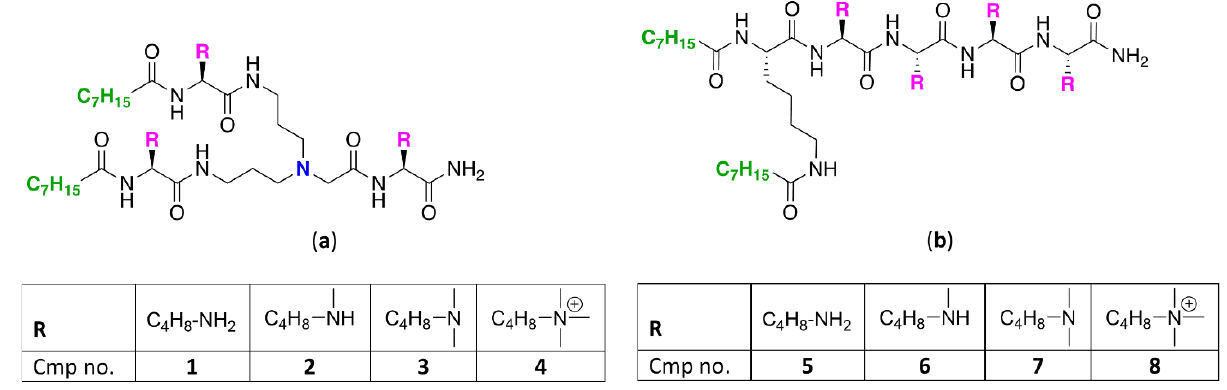
Figure 1. Structures of ( a ) branched and ( b ) linear UTBLPs.